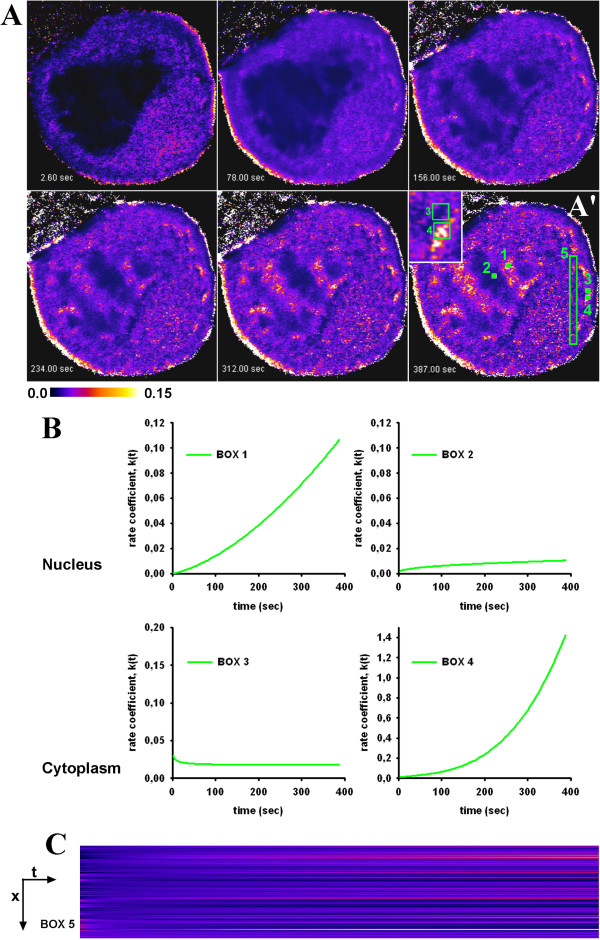
Pixel-wise rate coefficients of fluorescence loss kinetics of eGFP. Using the parameter maps of the FLIP analysis for the cell in Figure 4, rate coefficients were calculated for every pixel position, as outlined in Additional file. A, the resulting 32-bit image stack was color-coded using a FIRE-LUT, and selected frames of the rate coefficients were plotted (blue and yellow-white indicate low and high rate coefficients, respectively). Areas with accelerating speed of FL turn from blue to yellow-white over time. A’ few regions are highlighted with boxes (numbered ‘1’ to ‘5’) for further analysis. Boxes 1 and 2 were placed in the nucleus, while boxes 3 to 5 were in the cytoplasm (inset shows a zoom for the area containing boxes 3 and 4 close to the right edge of the cell). B, rate coefficients as function of time plotted for box 1 to 4. C, x,t-view of the time evolution of the rate coefficients in box 5. See text for further explanations.